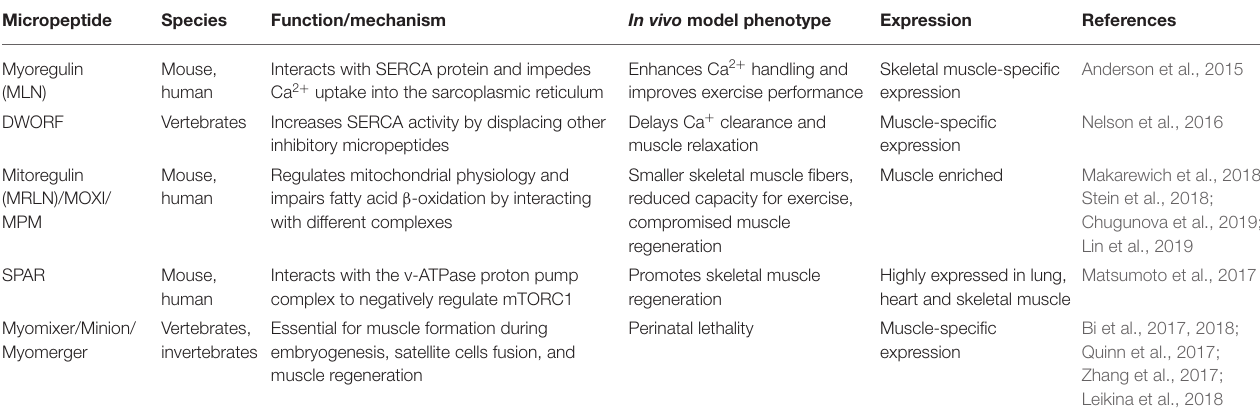
TABLE 3 | Functional long non-coding RNA (lncRNA)-derived micropeptides in skeletal and cardiac myogenesis.